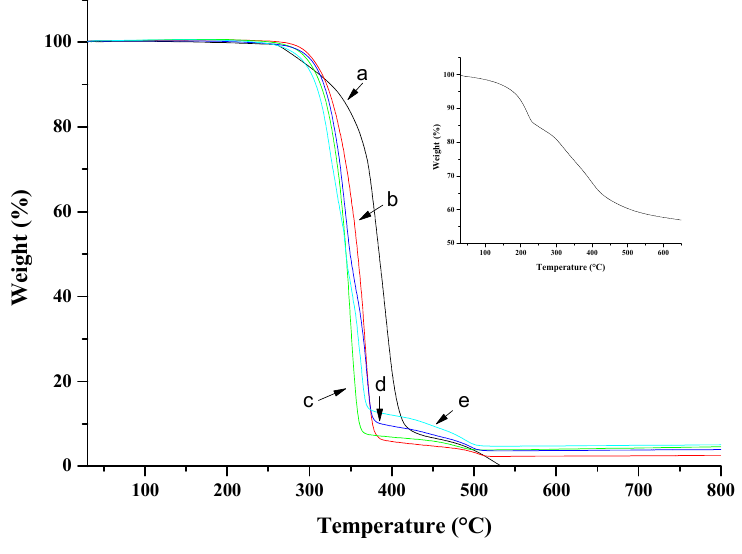
Figure 4. TGA analysis in air evaluated: PCL ( a ); PCL/1% LDH-EHT ( b ); PCL/3% LDH-EHT ( c ); PCL/5% LDH-EHT ( d ); and PCL/7% LDH-EHT ( e ). The inset reports the TGA on LDH-EHT.